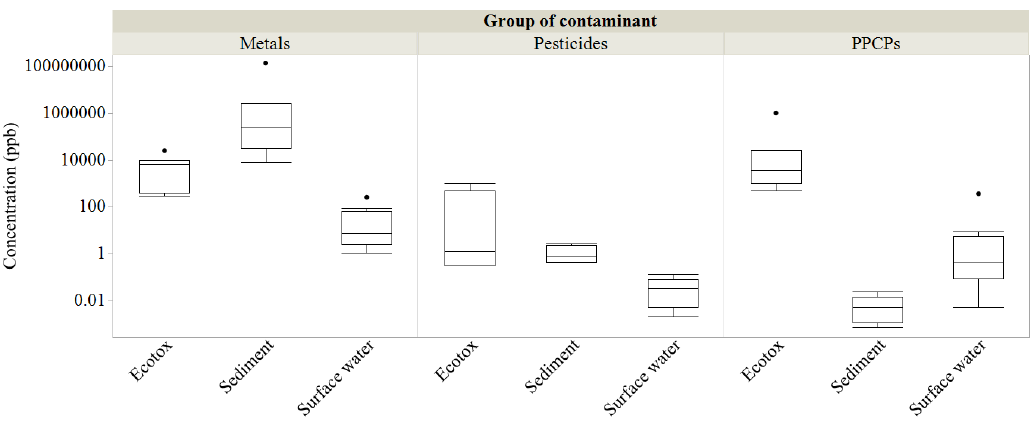
Figure 1. Concentrations of metals, pesticides and pharmaceuticals and personal care products (PPCPs) in the Brazilian aquatic ecosystem and ecotoxicological data. Sources: Almeida & Weber (2009); Alves et al. (2014); Beretta et al. (2014); Bonai et al. (2009); Brix et al. (2011); Costanzo et al. (2005); Ferreira (2005); Ghiselli (2006); Gibson et al. (2009); Gonçalves (2016); Han et al. (2010); Imai et al. (2005); Kim et al. (2012); Koprivnikar & Walker (2011); Kouyoumjian & Uglow (1974); Laabs et al. (2002); Lee et al. (2011); Liao et al. (2003); Locatelli et al. (2011); Montagner & Jardim (2011); Montagner et al. (2014); Monteiro et al. (2016); Oliveira et al. (2009); Partridge & Lymbery (2009); Pascoe et al. (2002); Pereira et al. (2016); Pestana et al. (2007); Pickering et al. (1962); Devi Prasad & Devi Prasa (1982); Rissato et al. (2006); Sanders et al. (1981); EPA